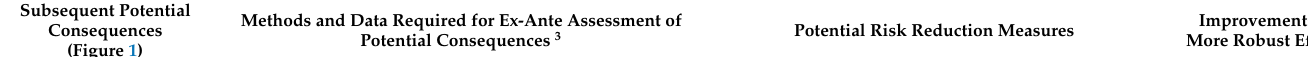
Methods and Data Required for Ex-Ante Assessment of Potential Consequences